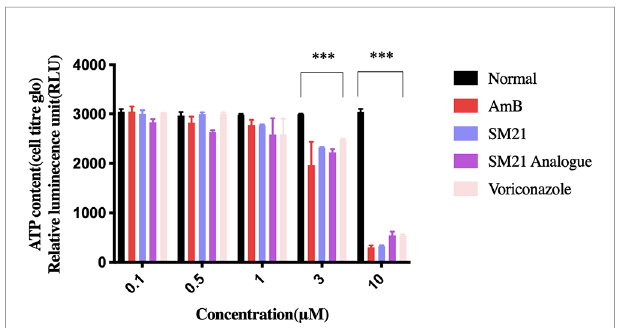
FIGURE 1 | Evaluation of ATP metabolism. Concentration-response curve of cell viability in immortalized human proximal tubule epithelial cell line (HK-2) measured by the CellTiter-Glo® Luminescent Cell Viability assay. Trials were performed in triplicate from independently fi ve times by use of different cell passages; non-treated cells with PBS in 1% DMSO used as vehicle. Each drug demonstrated dose-dependent depletion in ATP luminescence (signi fi cant difference observed from 1 – 10 m M). Signi fi cantly difference deemed as ***P < 0.001 relative to